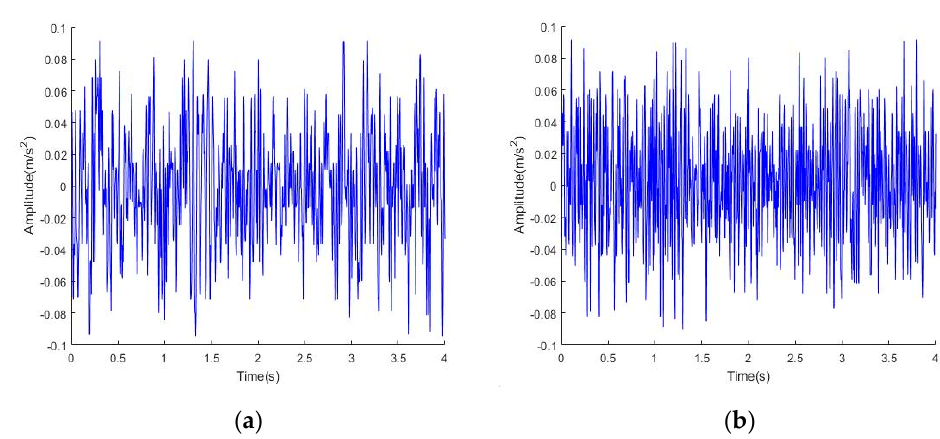
Figure 7. Elevator horizontal vibration signal: ( a ) X -axis vibration signal; ( b ) Y -axis vibration signal.